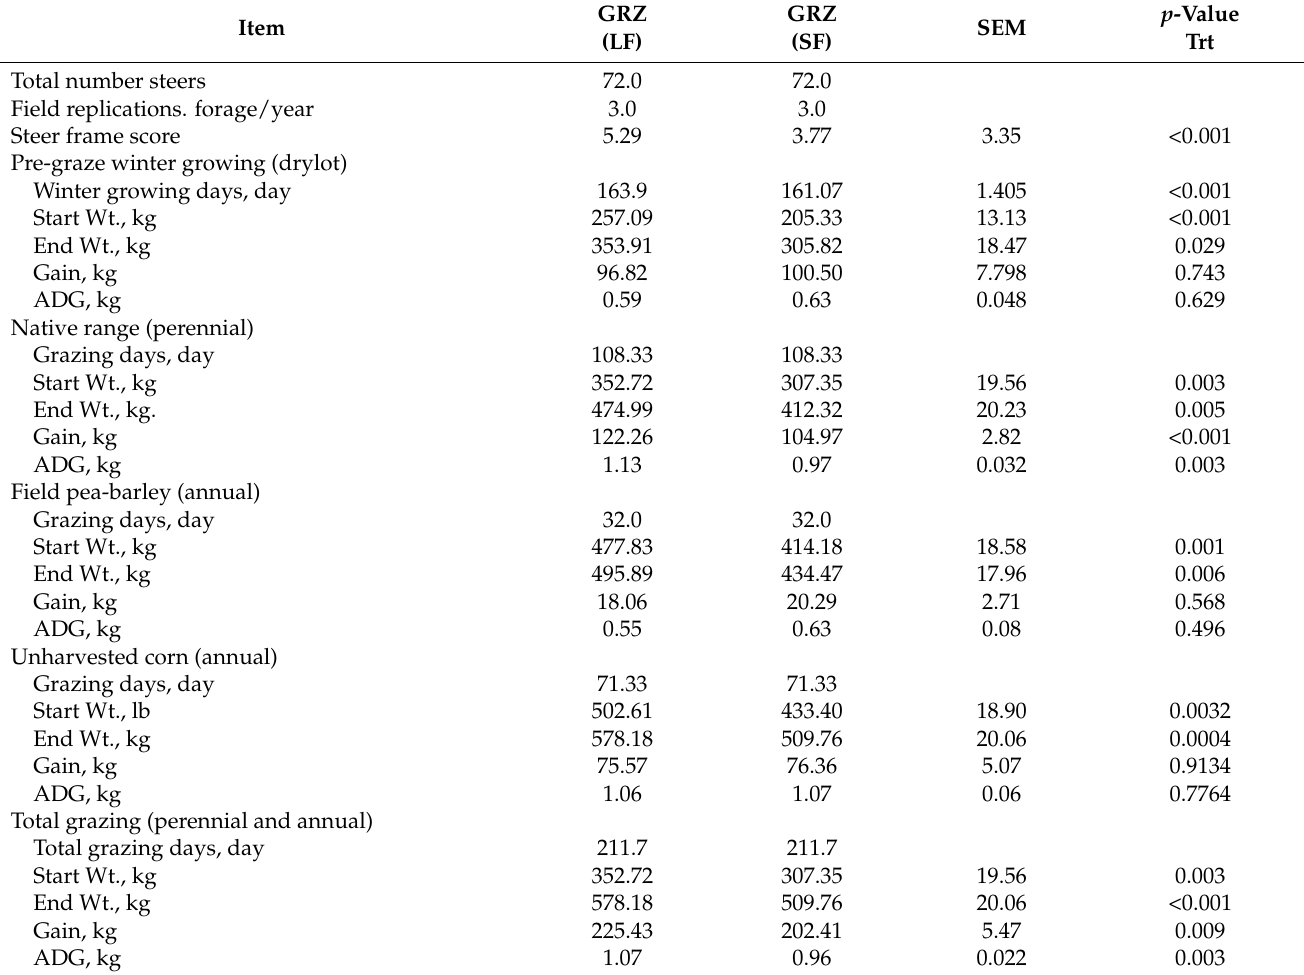
Table 5. Effect of forage sequence and extended grazing on yearling beef steer grazing performance 1